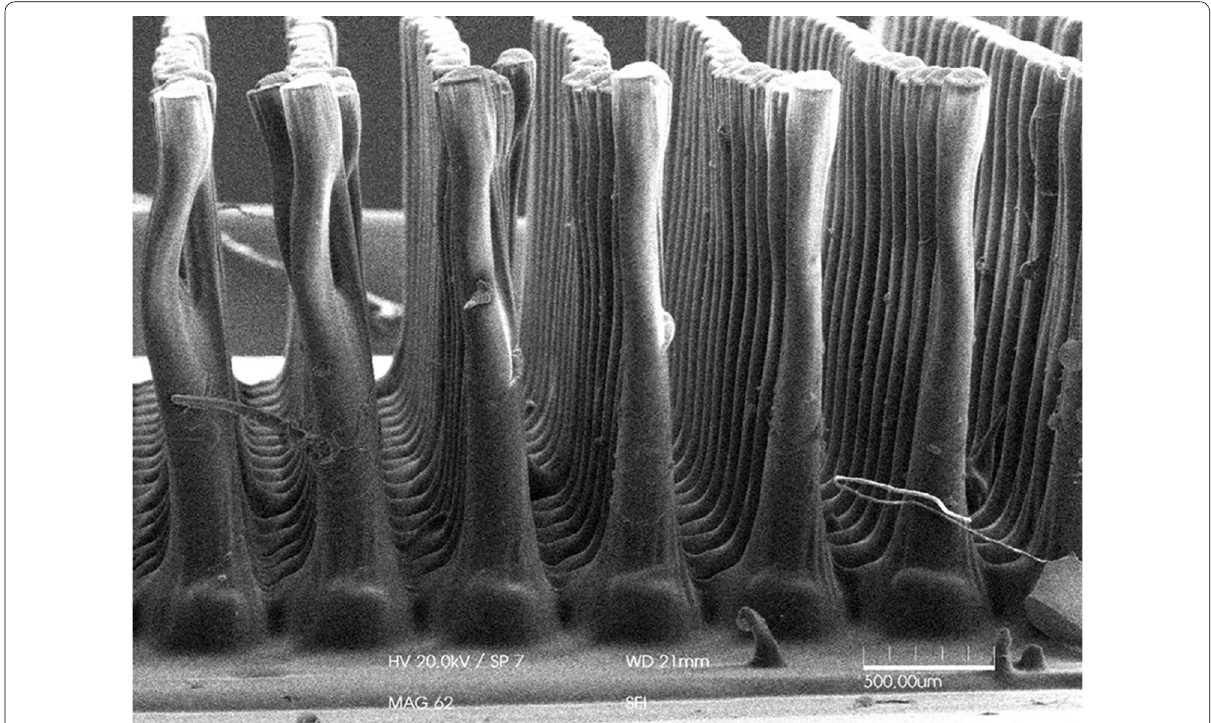
Fig. 2 Conventional lithography for 2000-µm-tall microtowers, resulting in an enlarged bottom and wavy sidewall